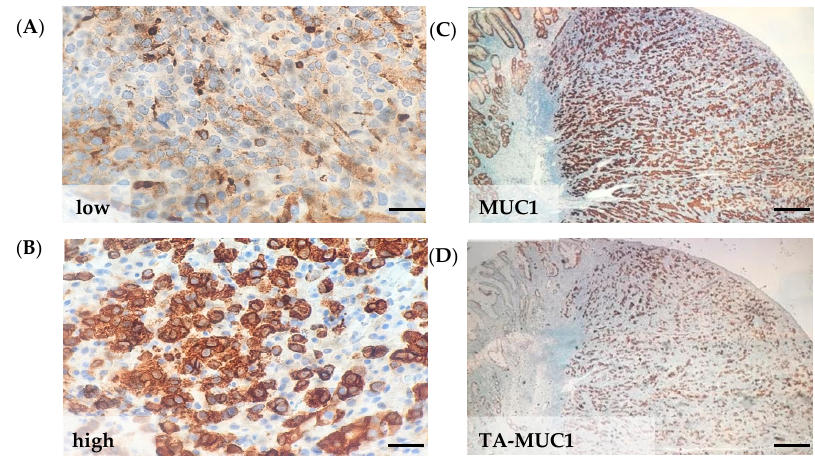
Figure 2. MUC1 and tumor-associated MUC1 protein expression in AN gastric cancer tissue. Representative MUC1 protein expression ( A ) low and ( B ) high in FFPE tumor tissue. Representative patient with ( C ) MUC1 and ( D ) tumor-associated MUC1 (TA-MUC1) expression. Scale bars; left panel, 25 μ m and right panel 250 μ m.